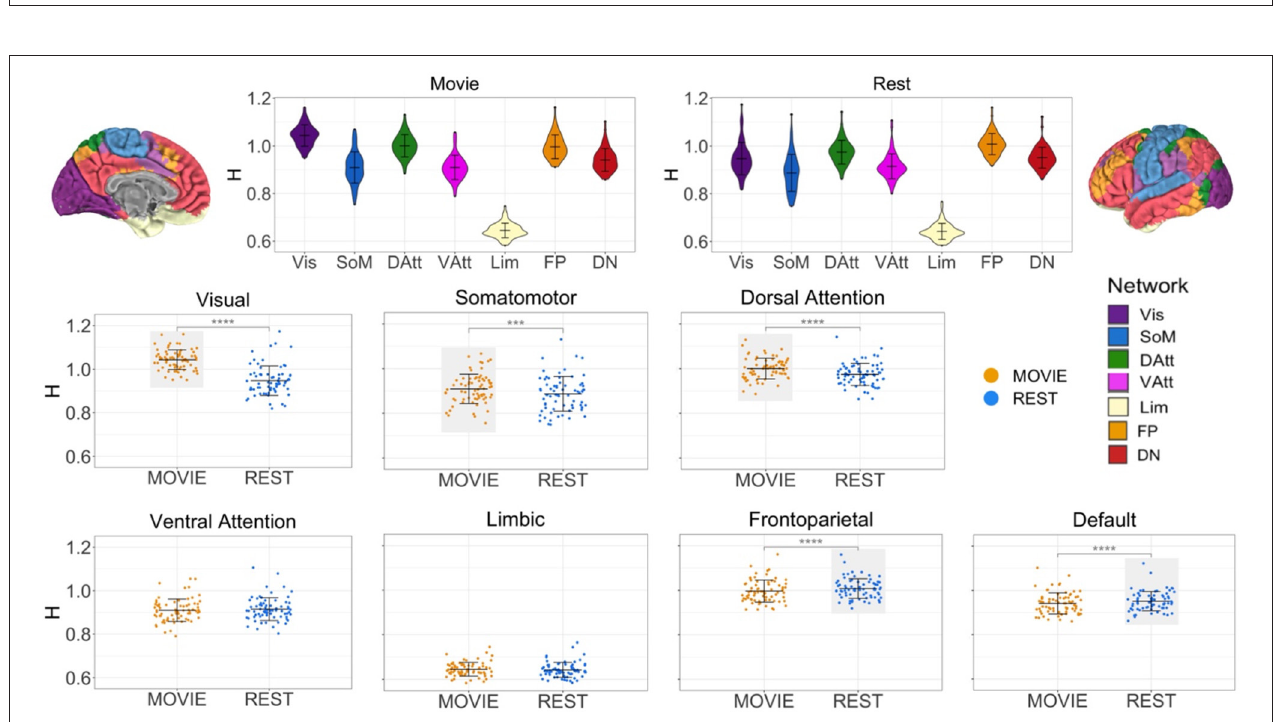
FIGURE 3 | H across conditions, by intrinsic connectivity network ( N = 72). Top center: violin plots for Movie and Rest showing H values of seven resting state networks (RSNs) from Yeo et al. Brains at the top left and right show topography of those networks using the same colors. H values ranged from 0.69 to 1.24, suggesting that BOLD signal within all networks demonstrates self-similarity. Bottom: scatter plots of H by condition for each RSN separately. Horizontal lines show the mean and standard deviation of H. Light gray boxes highlight which condition (Movie or Rest) had the higher statistically significant average value. Three networks had higher H values during Movie (visual, somatomotor and dorsal attention networks), and two networks had higher H values during Rest (frontoparietal and default networks).